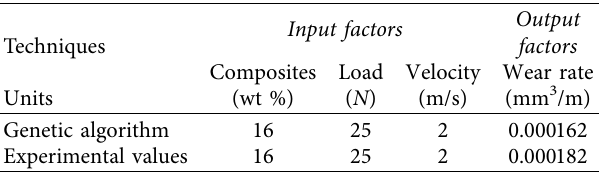
Table 9: Comparison of genetic algorithms and experimental